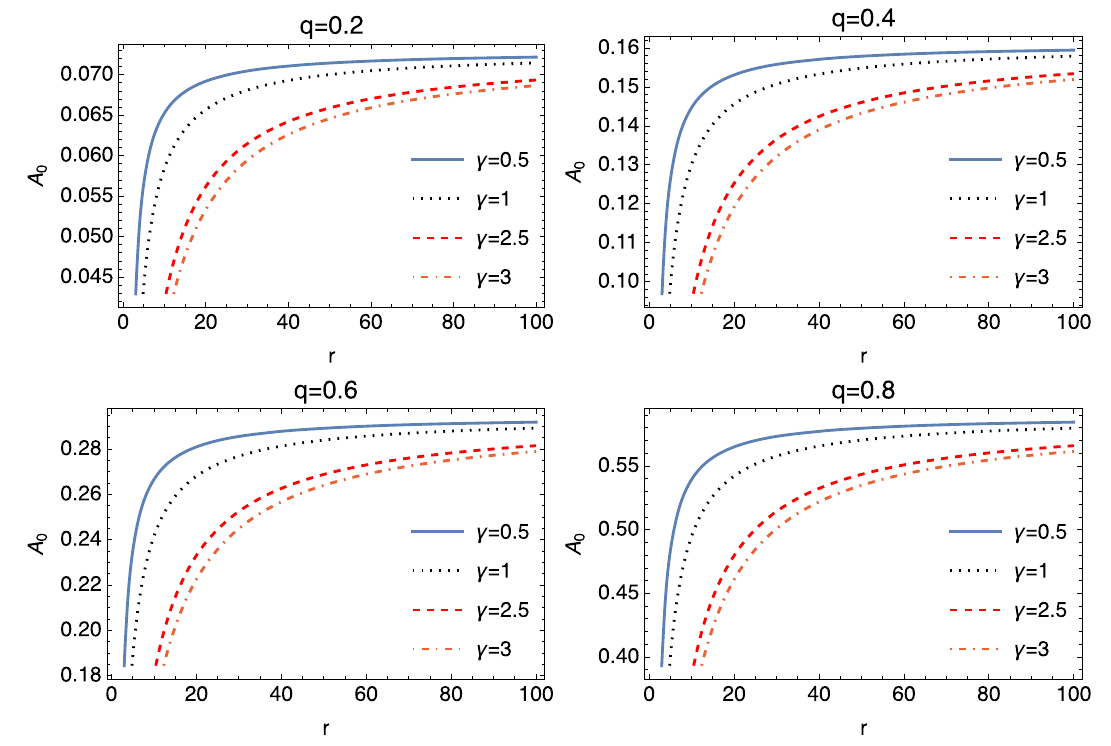
Fig. 1 Radial dependence of the electric potential in the charged ZV metrics. Plots are generated for m = 1 and different values of γ and charge related parameter